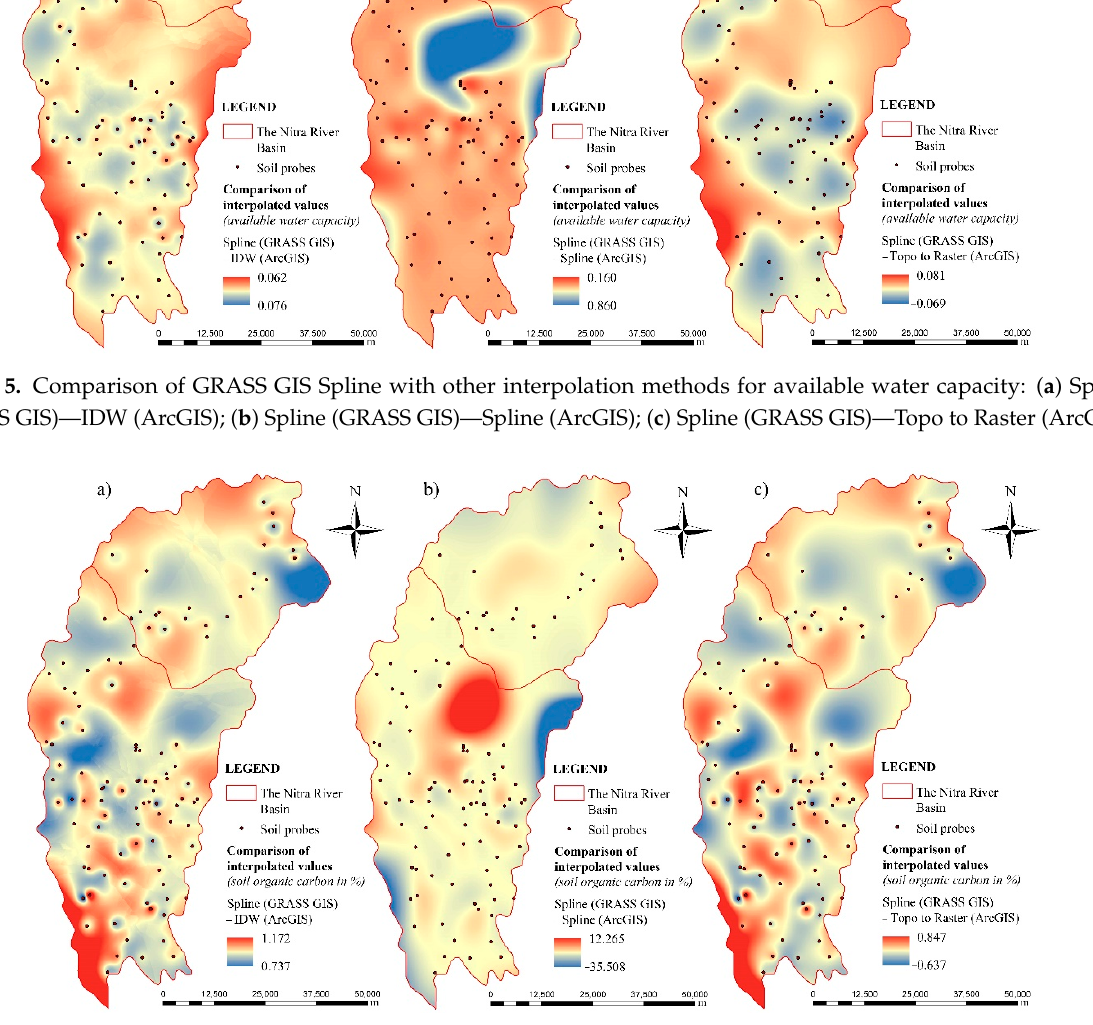
Figure 7. Comparison of GRASS GIS Spline with other interpolation methods for clay fraction content <0.001 mm: ( a ) Spline (GRASS GIS)—IDW (ArcGIS); ( b ) Spline (GRASS GIS)—Spline (ArcGIS); ( c ) Spline (GRASS GIS)—Topo to Raster (ArcGIS).